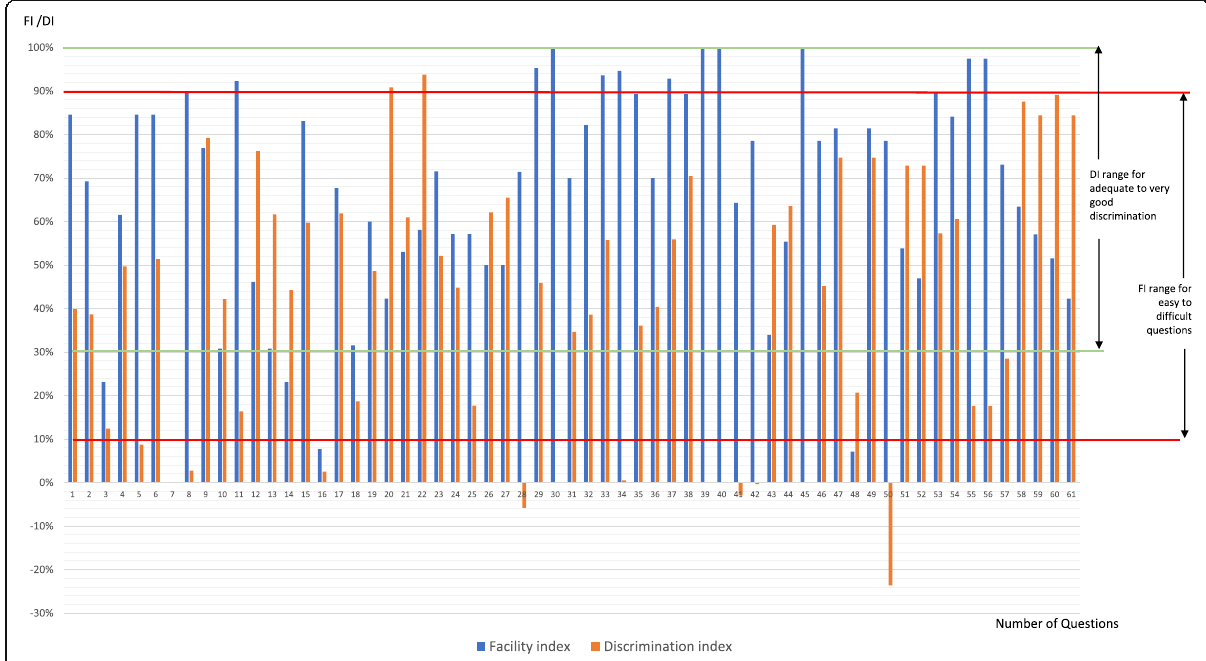
Fig. 11 Analysis of FI and DI when evaluating the questions for revision